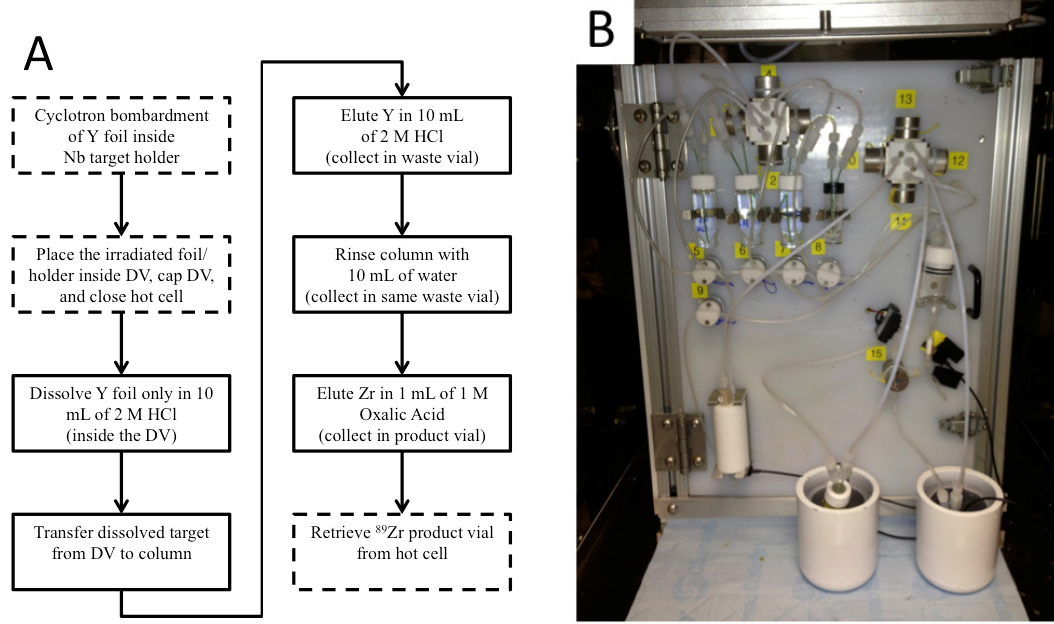
Figure 2. ( A ) A flowchart describing the process for production and chemical separation of 89 Zr from an irradiated Y foil. Bold text indicates automated steps; dashed line, steps that are currently performed manually; ( B ) A photograph of the automated